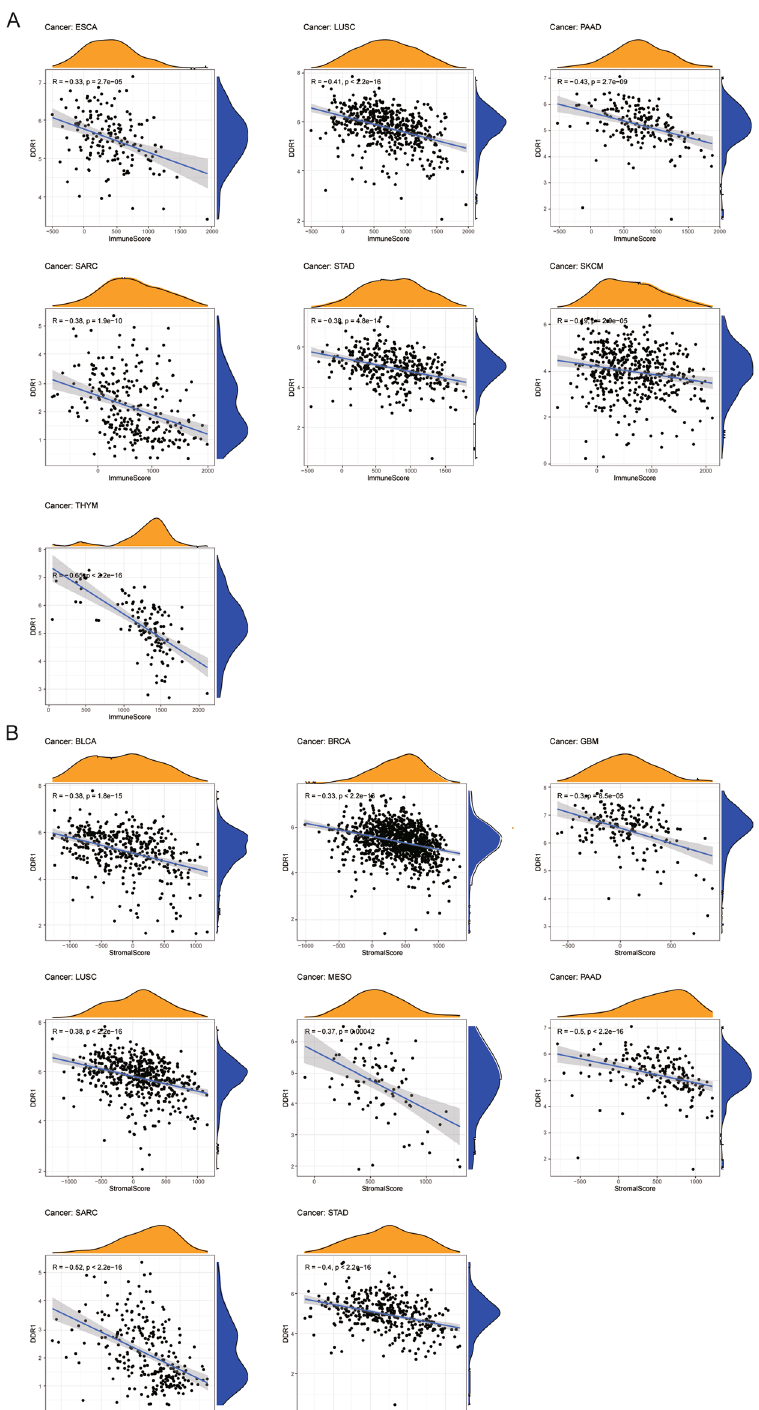
Figure 7. Eleven tumors with the highest correlation coefficients between DDR1 expression and the tumor microenvironment. ( A ) Correlation between DDR1 and immune scores in ESCA, LUSC, PAAD, SARC, STAD, SKCM, and THYM. ( B ) Correlation between DDR1 and stromal scores in BLCA, BRCA, GBM, LUSC, MESO, PAAD, SARC, and